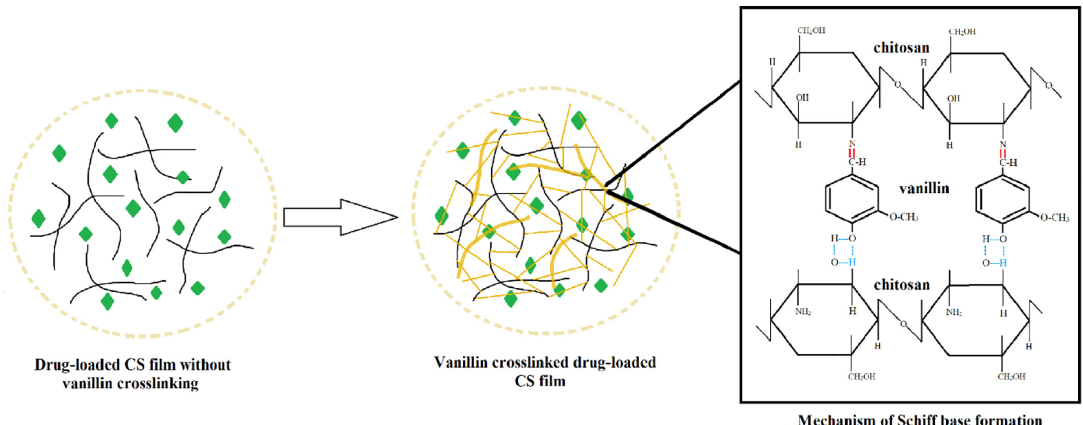
Figure 3. The mechanism of Schiff base formation between chitosan and vanillin (reprinted from [156]. Copyright (2021), with permission of Elsevier).